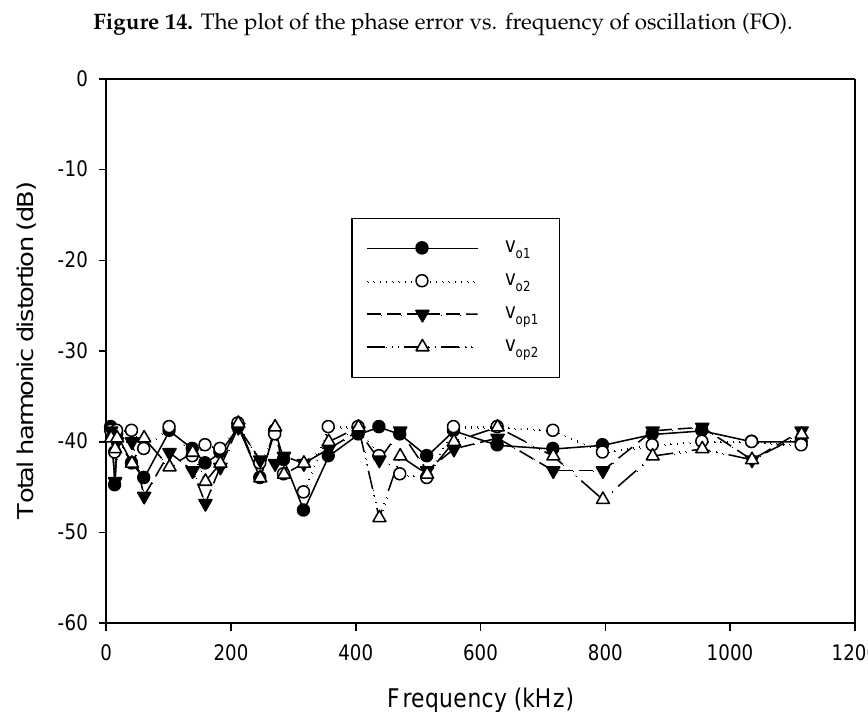
Figure 14. The plot of the phase error vs frequency of oscillation (FO).